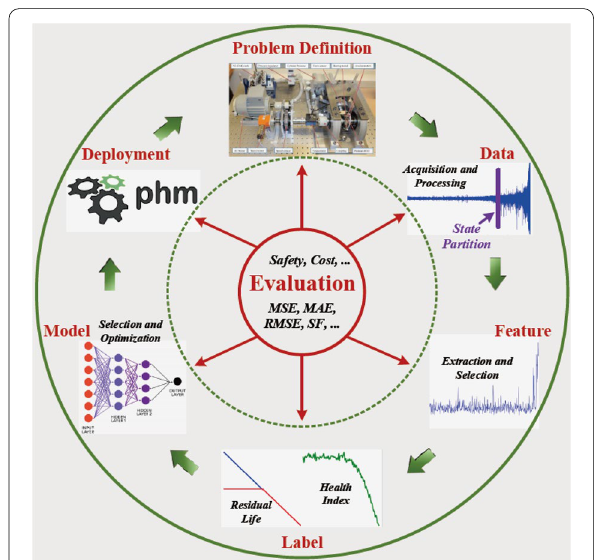
Figure 5 Flowchart of RUL